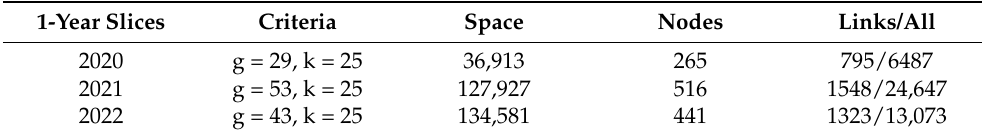
Table 5. Literature co-citation network attributes in each year. 1-Year Slices Criteria Space